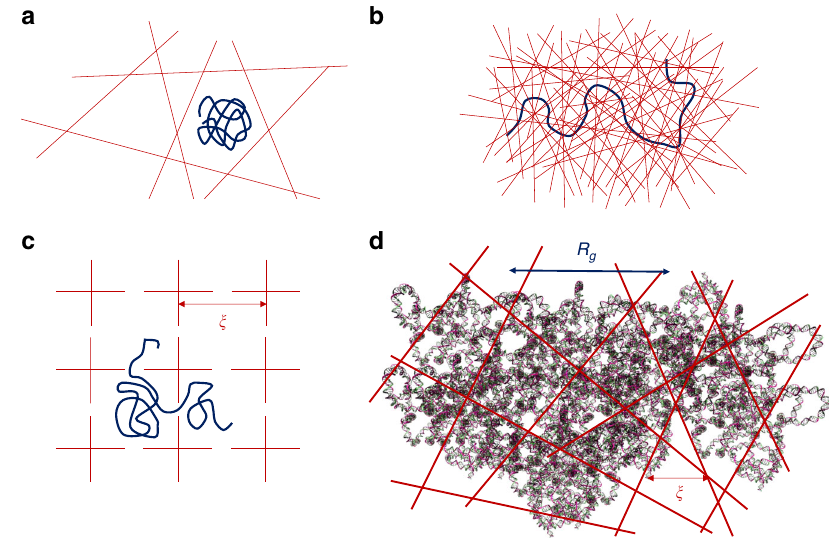
Fig. 1 Three familiar models of macromolecular transport under con fi nement, and the topologically frustrated dynamical state. a Ogston ’ s model, b Reptation, and c Entropic Barrier. d Cartoon of topological frustration when large guest macromolecules are crowded in a gel matrix. In c , where R g of the guest molecule is comparable to the mesh size ξ of the gel, the molecule diffuses by negotiating essentially single entropic barriers. In d , R g is much bigger than the mesh size ξ which itself is suf fi ciently big to hold large numbers of fl uctuating monomers. Each macromolecule occupies tens of meshes with a family of local relaxation rates, and redistribution of portions of the molecule involves multiple entropic barriers which are strongly correlated. All of these barriers must be simultaneously breached by the guest molecule for it to move a distance comparable to its size. The required enormous time for this correlated process results in the non-diffusive topologically frustrated